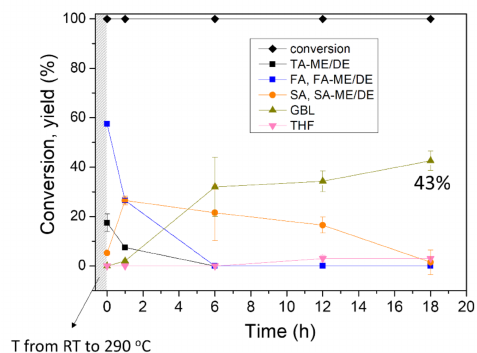
Figure 5. Reaction profile of the conversion of tartaric acid (TA) at 290 ◦ C. Reaction conditions: batch reaction, ReO x NPs (10 mg, 4 mol% Re relative to substrate), TA (1 mmol), i -PrOH (10 mL), and N 2 (15 bar). Conversion and yield are calculated by 1 H NMR and